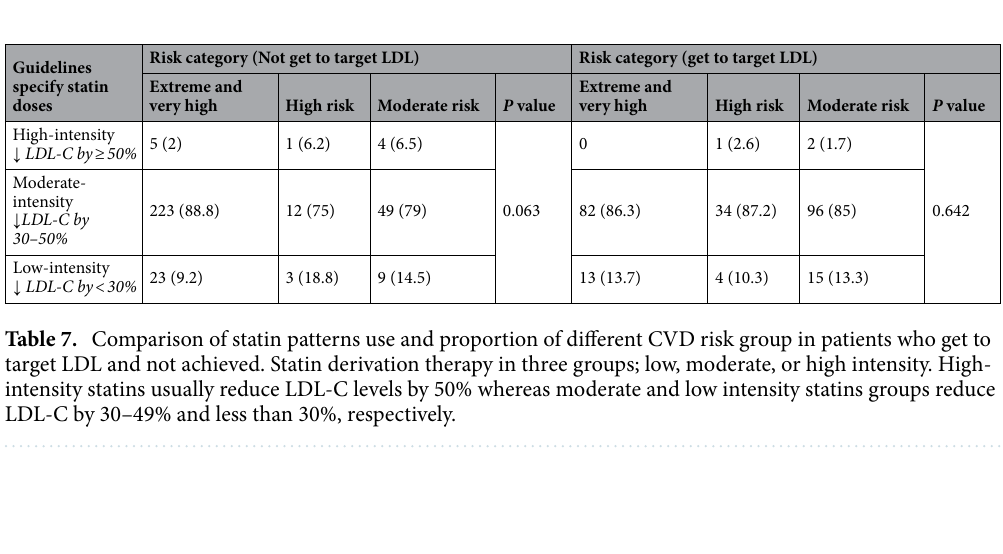
Table 6. Patterns of statin use and proportion of total patients in CVD risk groups. Statin derivation therapy in three groups; low, moderate, or high intensity. High-intensity statins usually reduce LDL-C levels by 50% whereas moderate and low intensity statins groups reduce LDL-C by 30–49% and less than 30%, respectively.